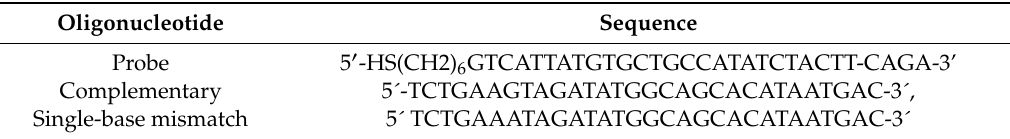
Table 1. DNA sequences used in this study.